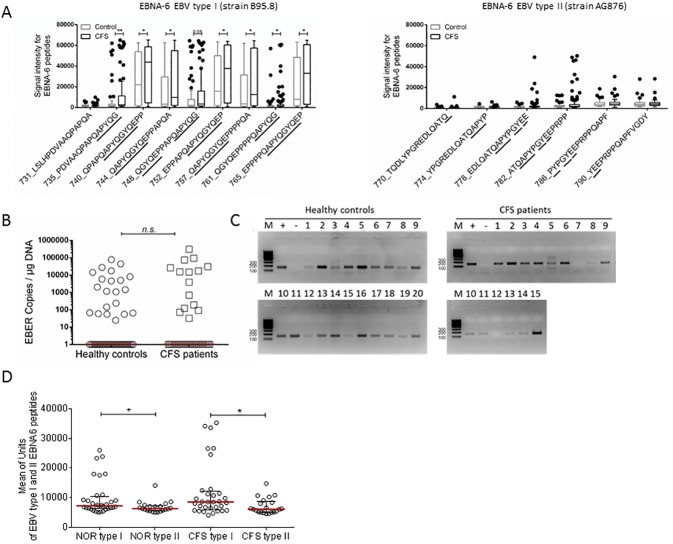
Reactivity against EBV type I EBNA-6.A) Seroarray data showing signal intensities for healthy controls (n = 50) and CFS patients (n = 92) against peptides from repeat region of EBNA-6_731–780 from strain B95.8 of type I EBV (left) and EBNA-6_770–805 from strain AG876 of type II EBV (right) containing the repeat sequence QAPYQGYQE. B) EBER copies were determined by qPCR of EBER-1 in throat washing samples of 50 healthy controls and CFS patients. C) EBER positive samples were tested for EBNA-6 DNA with primers discriminating EBV type I (B95.8) and II (AG876) by PCR. Gel electrophoresis shows 153 bp products corresponding to type I. Product of type II has an estimated size of 246 bp. As positive control (+) EBV type I cell line Namalwa DNA, as negative control (-) water was used instead of template DNA. D) Unique EBNA-6 peptides for EBV serotypes I (B95.8) and II (AG876) were compared for specific IgG response in 50 controls (NOR) and 92 CFS patients (CFS) by seroarray. Shown are EBNA-6 peptides that induced an IgG response of >5000 U in healthy controls (see S2 File). M—DNA ladder. Statistical analysis by Mann-Whitney-U test with n.s.—not significant, * p<0.05, ** p<0.01.